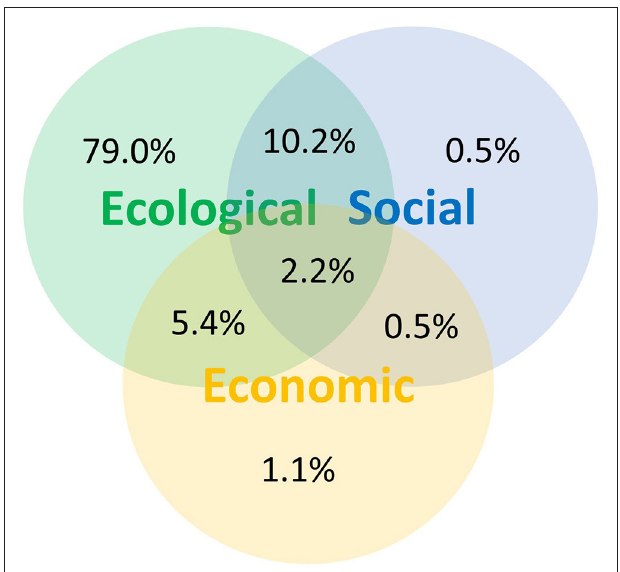
FIGURE 5 | Breakdown of outcomes reported by studies on the restoration of coral reefs, seagrass, mangroves, saltmarsh, and oyster